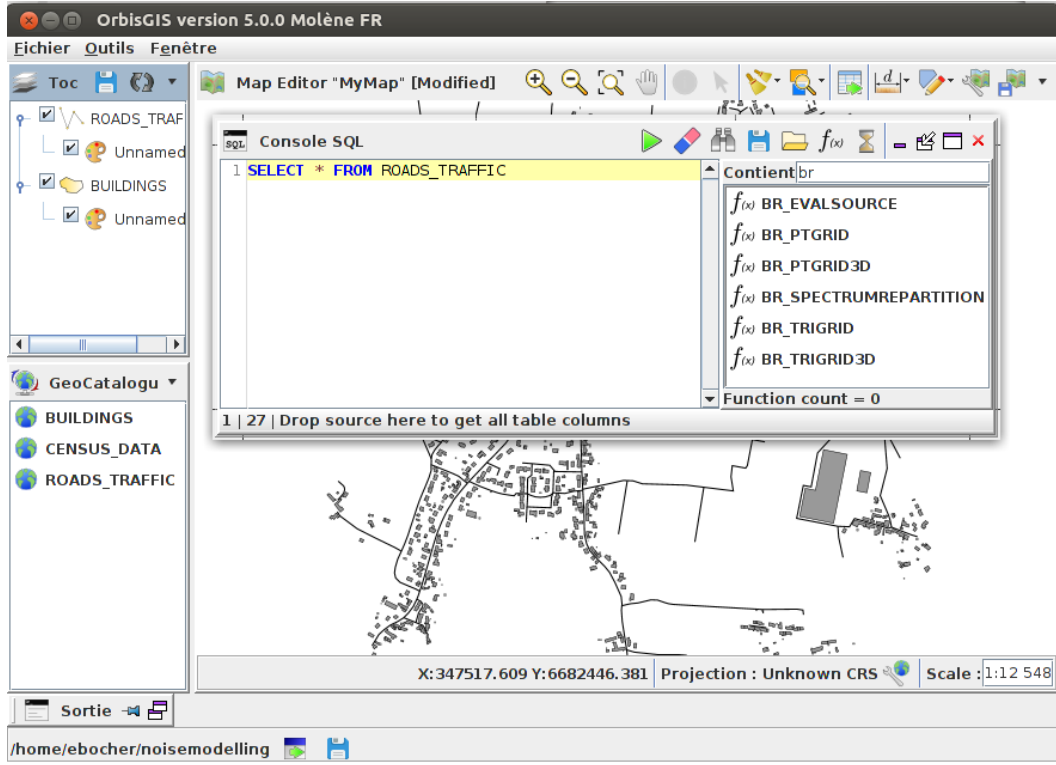
Figure 8. OrbisGIS Graphical User Interface (GUI) and its Structured Query Language (SQL)